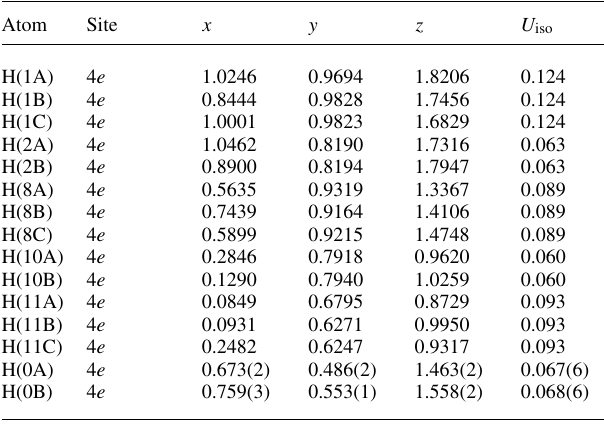
Table 2. Atomic coordinates and displacement parameters (in Å 2 )